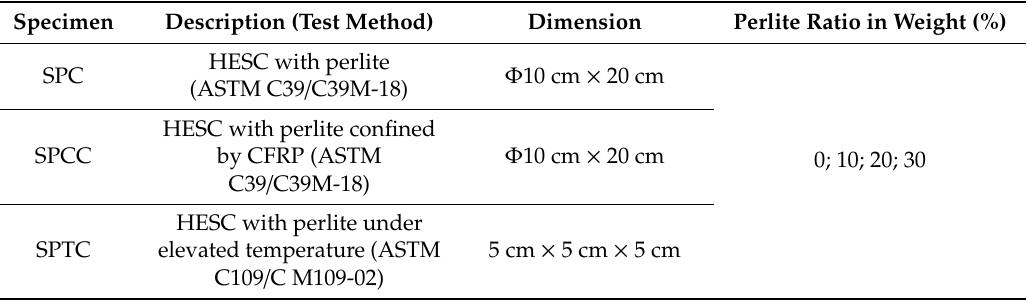
Table 5. The unconfined specimens’ dimensions and their corresponding test method.